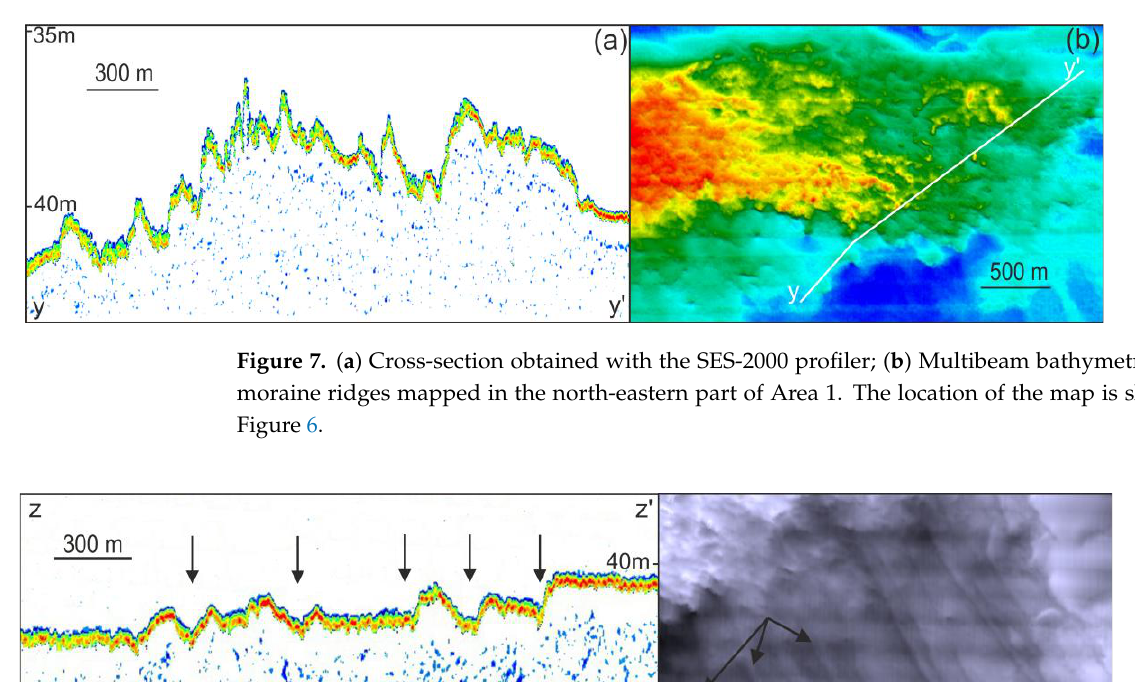
white arrow indicates the ice-flow pathway inferred from the glacial landforms. The black lines in Figure 6b point to glacial linear features.